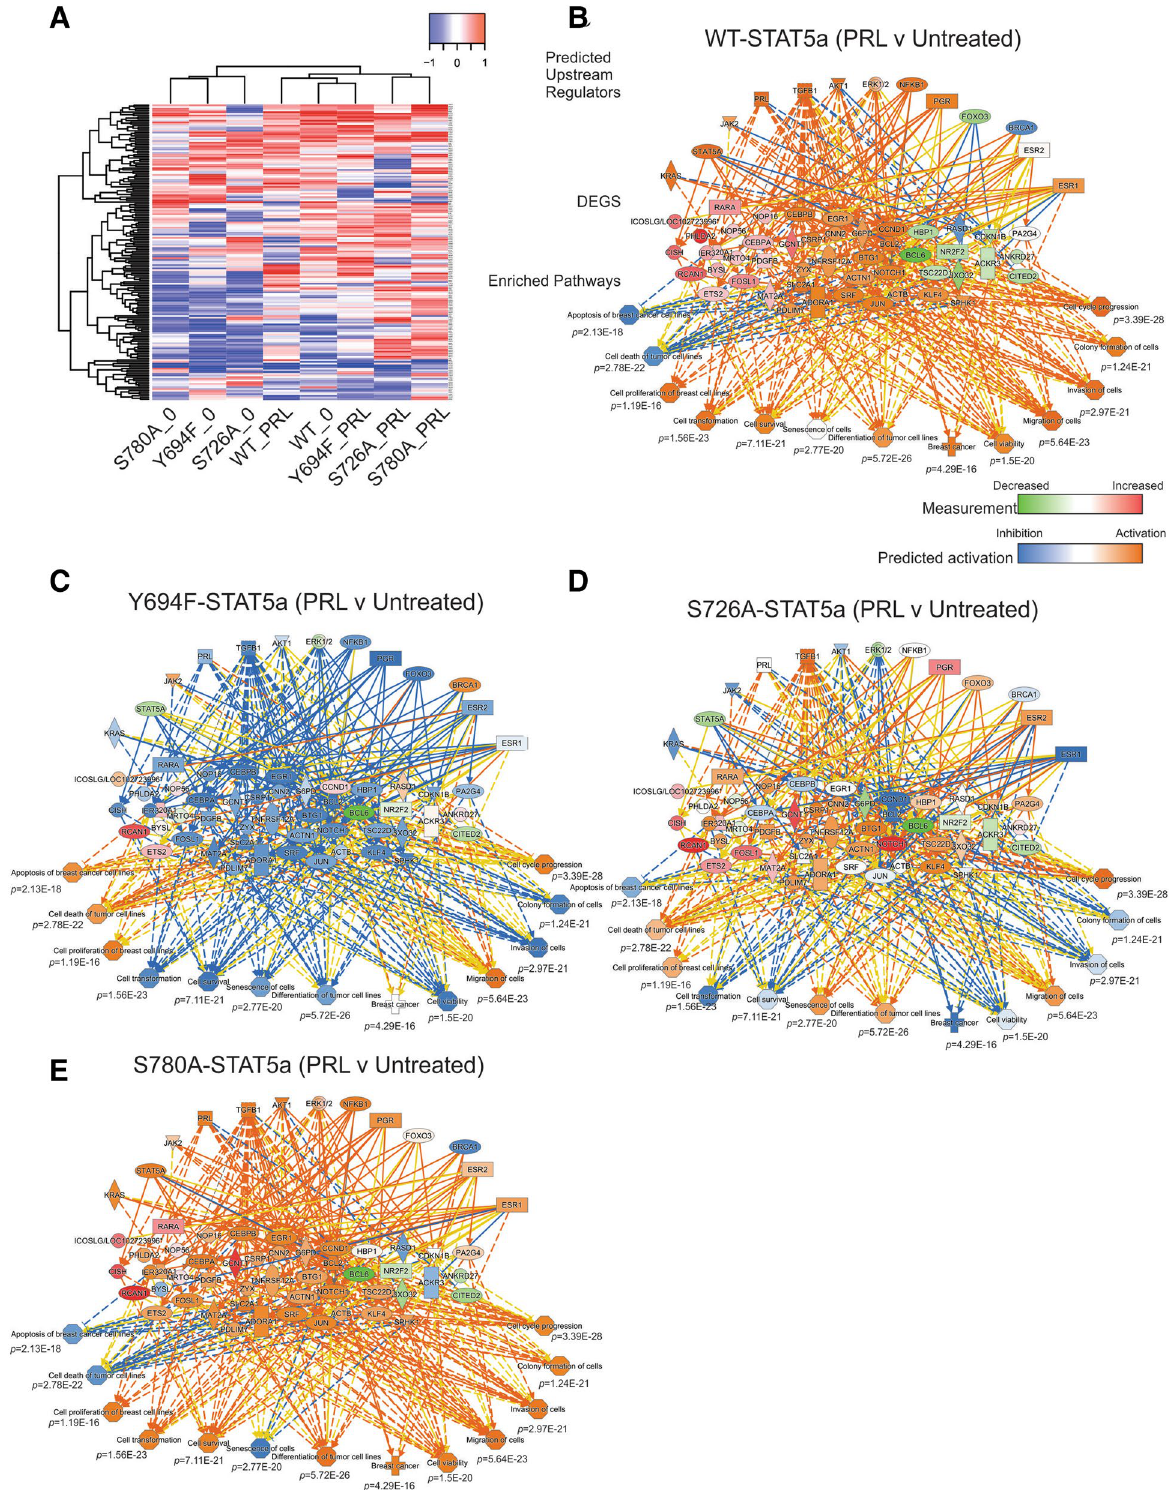
Figure 3. Expression of STAT5a phospho-mutants differentially affects PRL-regulated gene expression in MCF7 cells. ( A ) Supervised clustering of each STAT5a species’ top 50 DEGs (≥ 1.5-fold change) from RNA-seq analysis of PRL-treated versus untreated MCF7 cells expressing STAT5a rescues using the heatmap2 tool on www. usega laxy. org (Galaxy Version 3.0.1). ( B ) IPA functional pathway enrichment analysis shows upstream regulators and predicted pathway activation or inhibition with PRL treatment of WT-STAT5a-expressing MCF7 cells. ( C – E ) IPA functional pathway analysis of indicated STAT5a phospho-mutants overlaid with the regulatory network shown in panel B to predict activation or inhibition. p value calculated by Fisher’s exact test for networks generated in IPA with predicted effects based on the similarity of gene expression values to annotated network relationships in the Ingenuity knowledge base (IPA software 2020 Version 62,089,861,